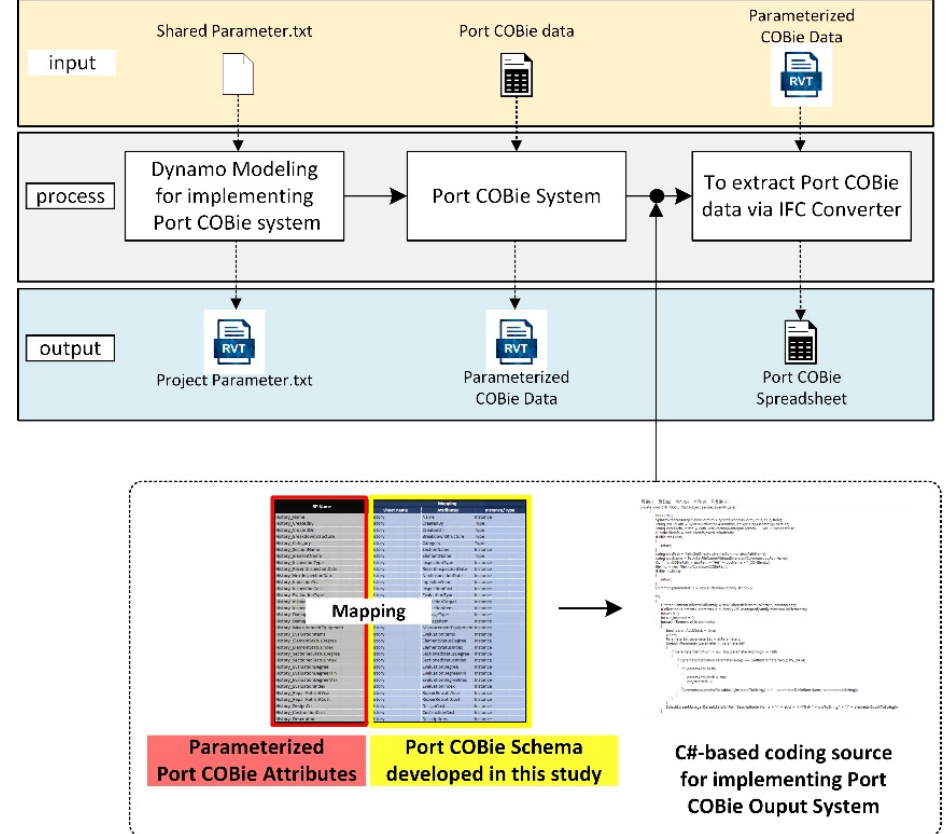
Figure 18. The entire implementation process for the port COBie system.